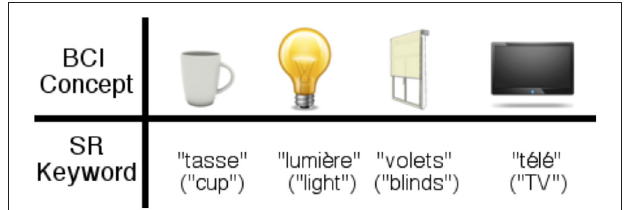
FIGURE 4 | Visual stimulations used for each concept for the conceptual BCI control. The cup toggles the kettle on or off, the lamp toggles the lights on or off, the blinds toggle the blinds to be raised or lowered and the TV triggers the TV on or off.